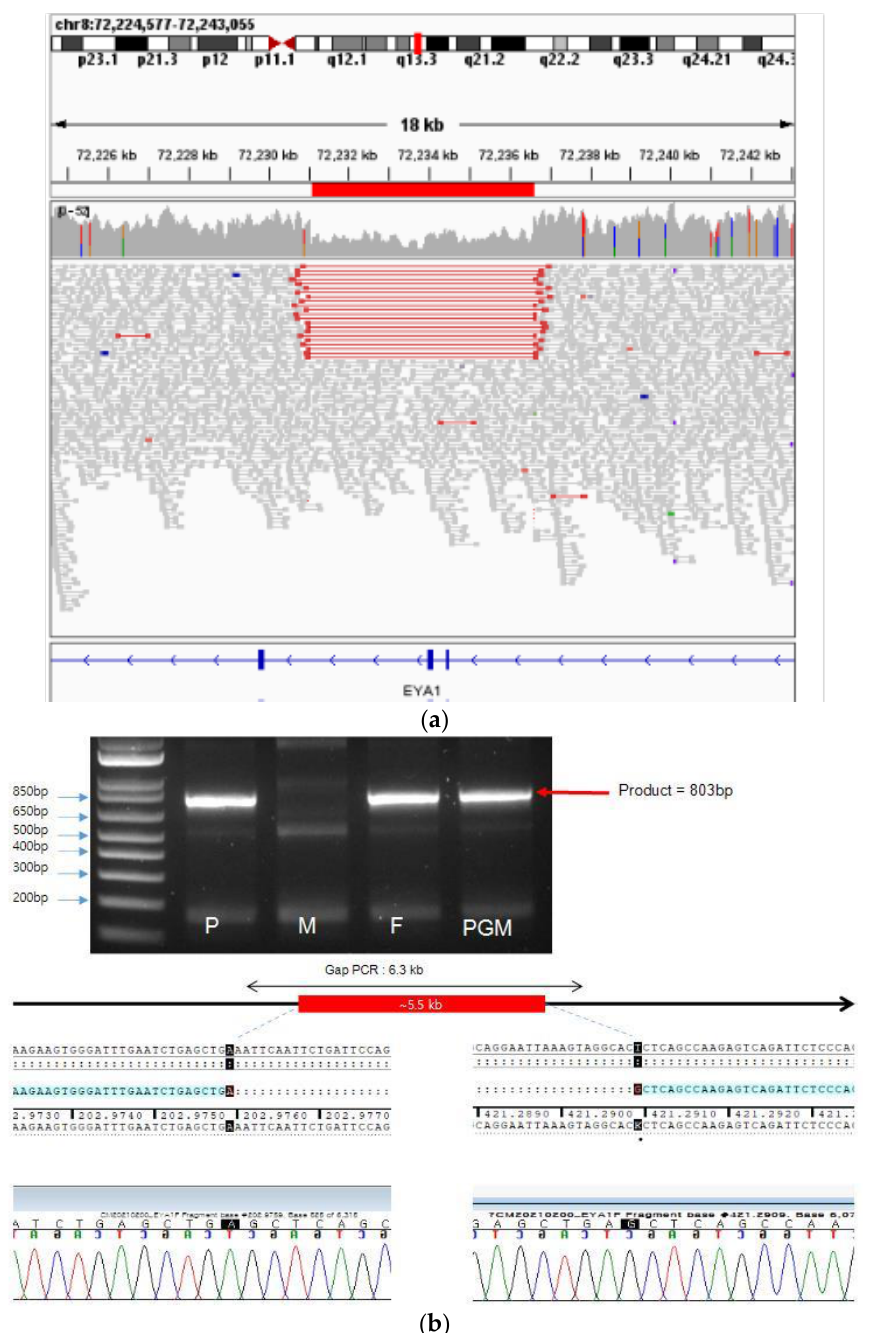
Figure 5. 5.5 kb deletion detected in EYA1 gene. ( a ) Discordant read pair detected in IGV. Suspected deletion spanning exon 5 and exon 6 of EYA1 is marked in red. ( b ) Gap PCR and Sanger sequencing of the suspected region. The deletion margin is confirmed with Sanger sequencing as NC_000008.10(NM_000503.6):c.203-2100_419-1133delinsG (chr8:72231057_72236603delinsC). P, proband; M, mother; F, father; PGM, paternal grandmother.